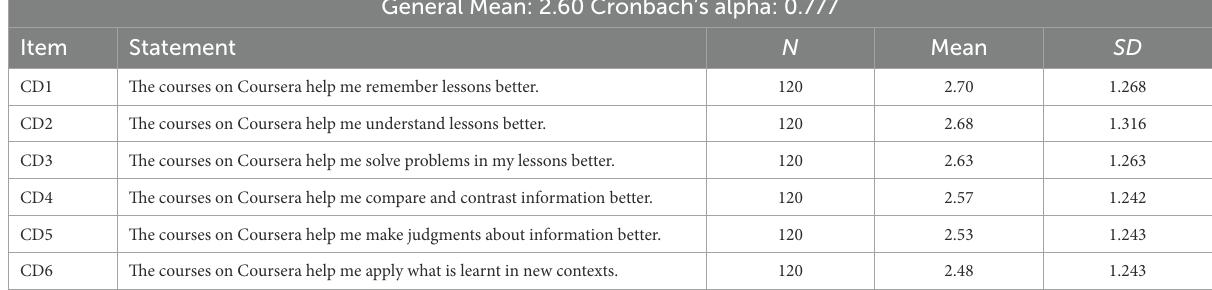
TABLE 3 Statistics for cognitive